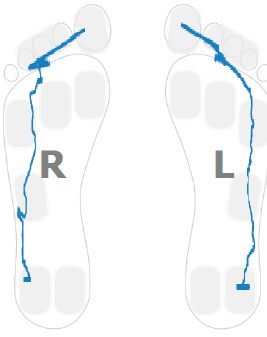
Figure 10. Pressure patterns for a stroke-survivor with RMI of 14.